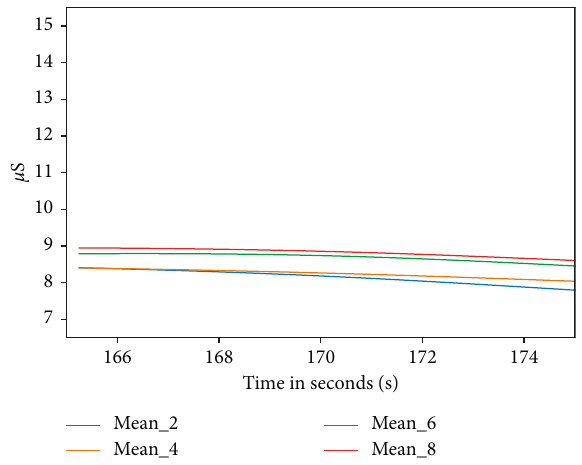
Figure 11: Plot of graphs of SCL averaged over all subjects for each density in the last ten